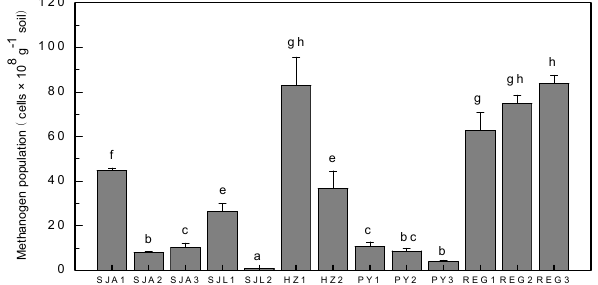
Fig. 4. Population of methanogenic archea in vertical profile soils of the Sanjiang Plain C. angustifolia (SJA1 = 0–20cm, SJA2 = 20– 40cm, SJA3 = 40–60cm) and C. lasiocarpa (SJL1 = 0–30cm, SJL2 = 30–60cm) marshes, Hongze wetland (HZ1 = 0–20cm, HZ2 = 20–40cm), Poyang wetland (PY1 = 0–10cm, PY2 = 10– 20cm, PY3 = 20–40cm) and Ruoergai peatland (REG1 = 0–10cm, REG2 = 10–20cm, REG3 = 20–40cm). Vertical bars denote stan- dard errors of means ( n = 3). Different letters indicate significant differences at P < 0 .